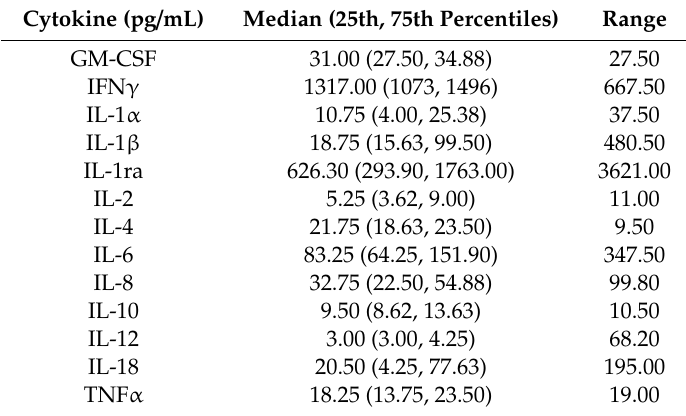
Table 1. Experiment 1: Cytokine concentrations in pig fresh seminal plasma samples (baseline samples, n = 20). Cytokines: Granulocyte macrophage colony-stimulating factor (GM-CSF), interferon-gamma (IFN γ ), interleukin (IL)-1 α , IL-1 β , IL-1ra, IL-2, IL-4, IL-6, IL-8, IL-10, IL-12, IL-18 and tumor necrosis factor- α (TNF α